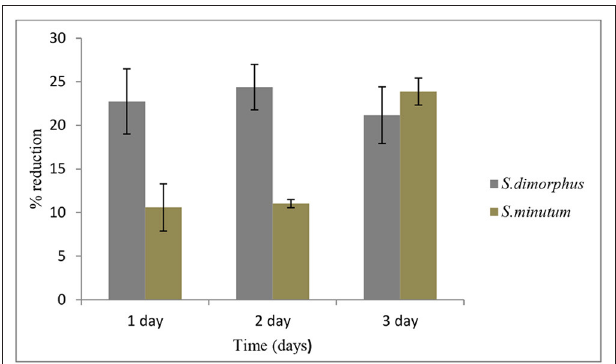
FIGURE 4 | Biomass reduction of S. dimorphus and S. minutum over time (D1, D2, and D3) in 5% salt stress. Biomass reduction values are presented as % reduction with the reference to day 0. Bars represent mean ± SE of five